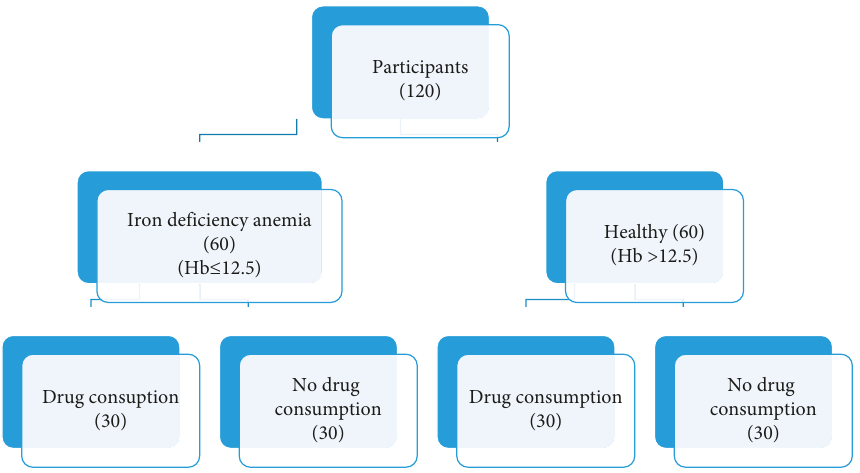
Figure 1: Details of participants in the study in different subgroups. Table 1: Comparison of the response to pulpal sensibility tests between anemic and healthy women. Anemic